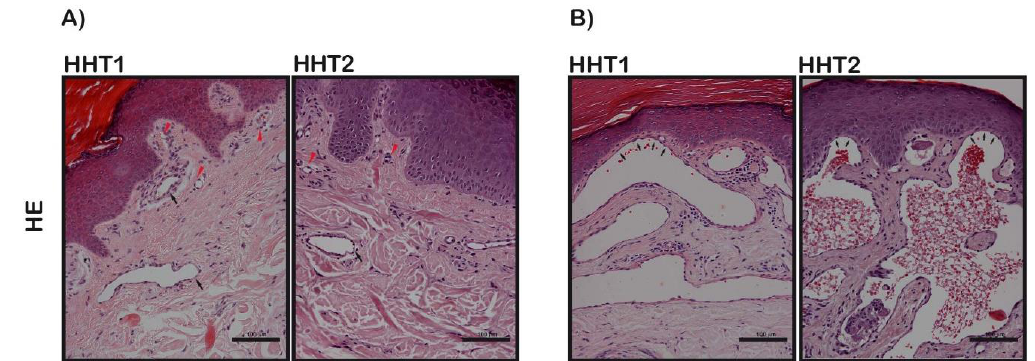
Figure 1. Hematoxylin and eosin (HE) microscope images. Scale bars, 100 µm. ( A ) Examples of conventional telangiectasia characterized by the presence of dilated microvessels at the superficial dermis (black arrows). Normal vessels are indicated with red arrows. One HHT1 patient and one HHT2. ( B ) Examples of more dilatated vessels expanding the papillary dermis between rete ridges that crowd up the epidermis layer (black arrows) (angiokeratoma-like pattern). One HHT1 patient and one HHT2. Table 2. Clinical characteristics of HHT patients according to different histological patterns. Conventional Pattern n (%) or Mean